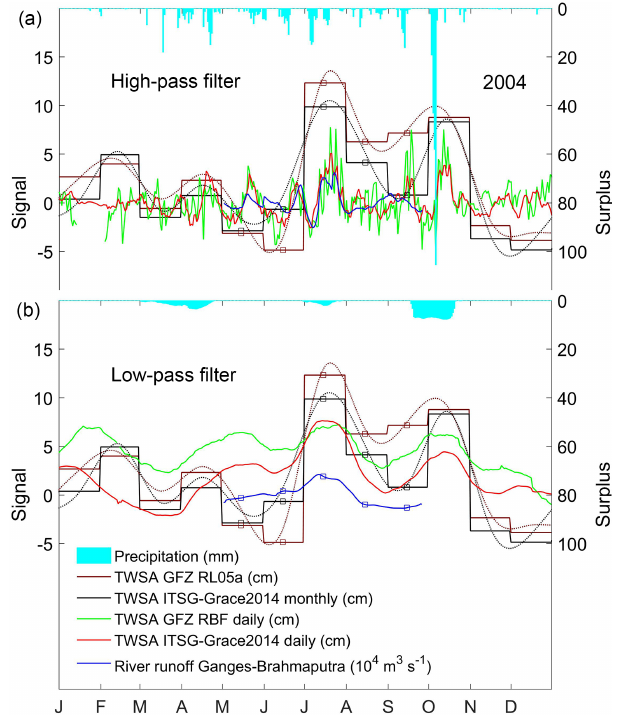
Figure 4. Daily and monthly area mean GRACE total water storage anomalies (TWSAs) and daily river runoff (left axis) together with the precipitation surplus (right axis) for the GBD in 2004. The daily data are separated into a high-frequency (a) and a low-frequency signal (b) by means of a 31-day high-pass filter. A series of cubic spline interpolations (dotted line) is fitted to the monthly solutions (step line). The squares represent (the number of) monthly values. The low-frequency signals and the monthly solutions have the mean seasonal cycle